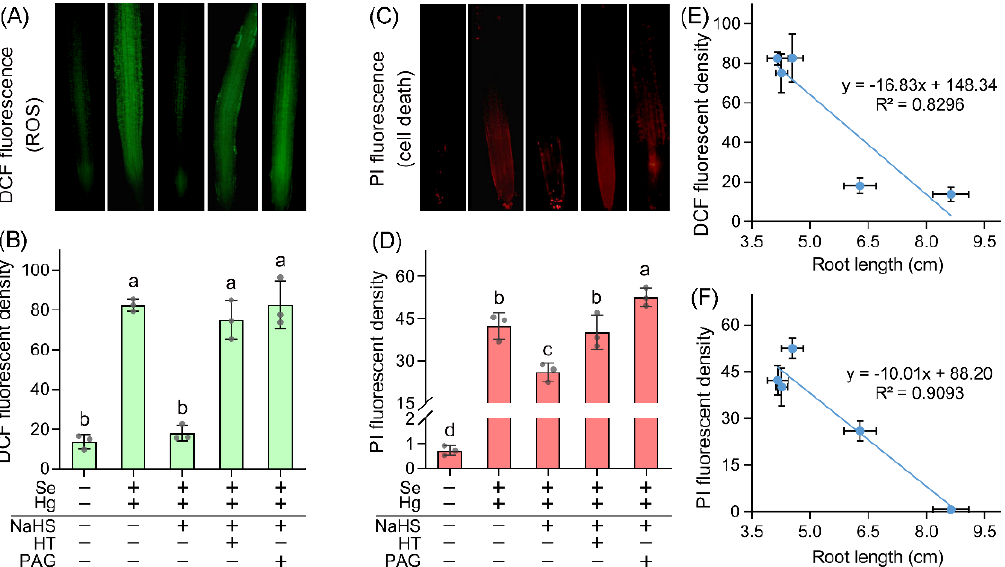
Figure 4. Endogenous H 2 S is involved in decreasing ROS accumulation and alleviating cell death in the root tip of B. rapa seedlings upon Hg + Se stress. ( A ) In situ detection of ROS accumulation with DCF fluorescence in root tip. ( B ) Calculated relative DCF fluorescent density in root tips. ( C ) In situ detection of ROS accumulation with PI fluorescence in root tip. ( D ) Calculated relative PI fluorescent density in root tips. ( E ) Correlation analysis between root length and DCF fluorescent density. ( F ) Correlation analysis between root length and PI fluorescent density. Different lowercase letters in ( B ) and ( D ) indicated significant difference among different treatments (ANOVA; n = 3; p < 0.05). ROS can attack cell membrane lipid, leading to loss of membrane integrity. This is